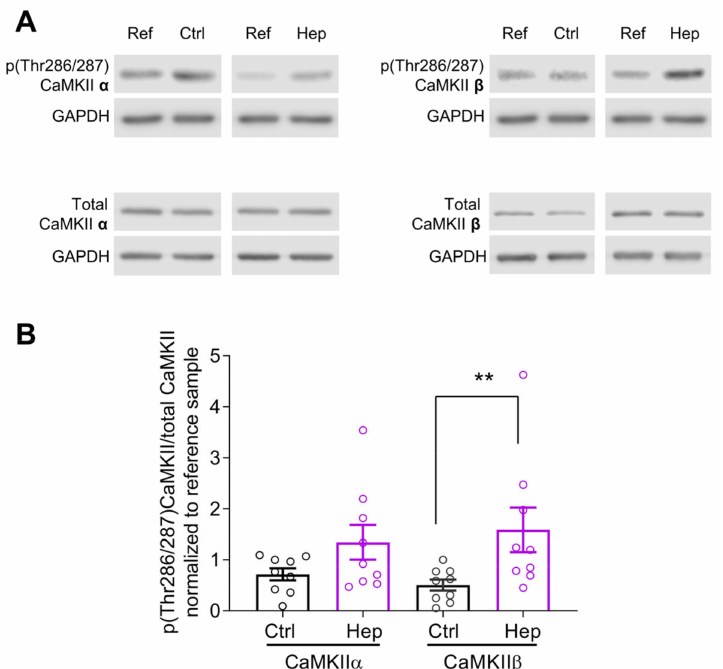
Figure 1. Heparinase treatment increased CaMKII activity in vivo. ( A ) Heparinase-injected mouse hippocampi were lysed, and extracts were used for immunoblotting. Membranes were incubated with anti-phospho-Thr286/287 CaMKII antibody to measure autophosphorylated CaMKII α and β levels relative to the total protein expression levels. ( B ) Summarized graph showing the statistical evaluation of Western blotting experiments, as in ( A ). Data are presented as means ± SEMs. Note that there was a significant increase in CaMKII β autophosphorylation one day after heparinase injection (** p < 0.01, Mann–Whitney–Wilcoxon test; Ctrl, n = 9; Hep, n =